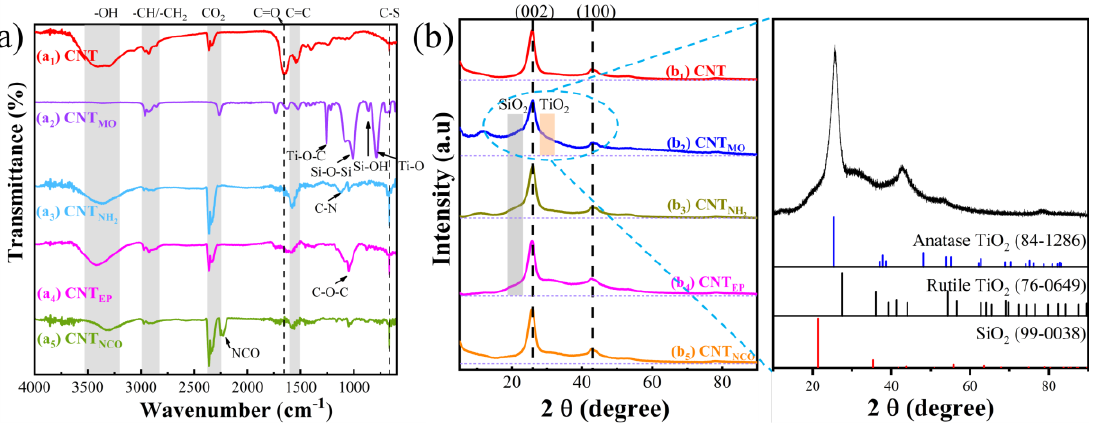
Figure 3. ( a ) FTIR spectra(a) and XRD results ( b ) of pristine and four modified CNT inorganic filler. Table 1. The representation of each